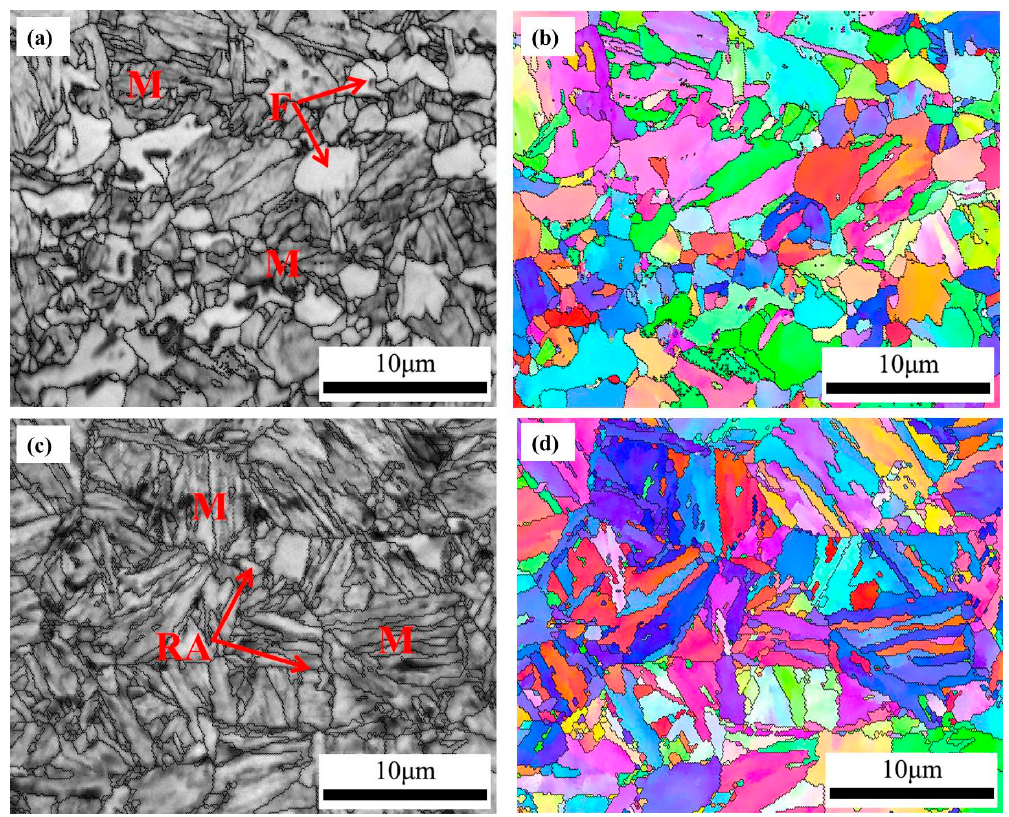
Figure 2. Microstructure of DP and QP steel prior to deformation. ( a , b ) Distribution of ferrite (F) and martensite (M) in DP steel. ( c , d ) Distribution of martensite (M) and retained austenite (RA) in QP steel.